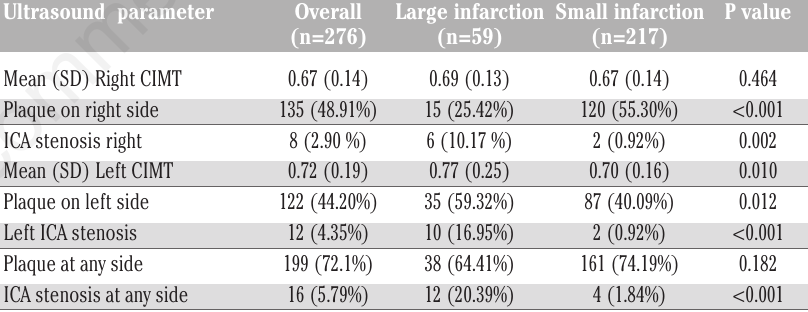
Table 2. Carotid duplex ultrasound parameters of thrombotic stroke patients classified by infarct size.